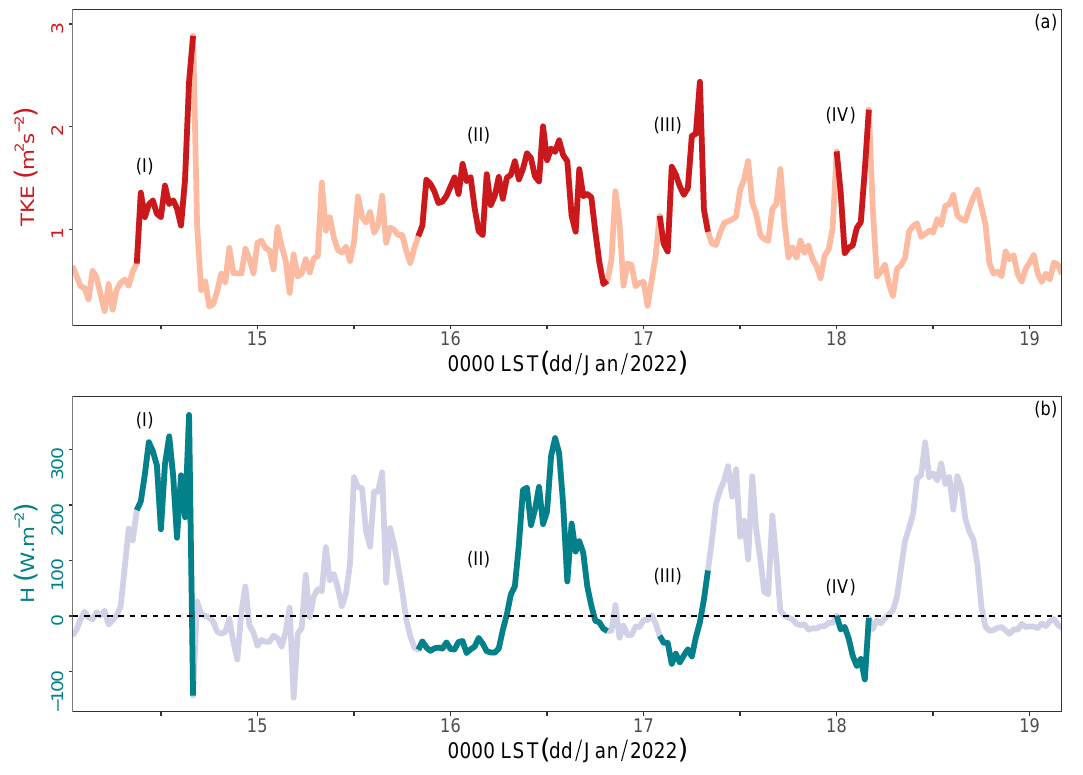
Figure 7. As shown in Figure 6, but for the: ( a ) turbulent kinetic energy ( TKE ); ( b ) sensible heat flux ( H ). The highlighted periods, indicated by dark colors, represent episodes of DWs